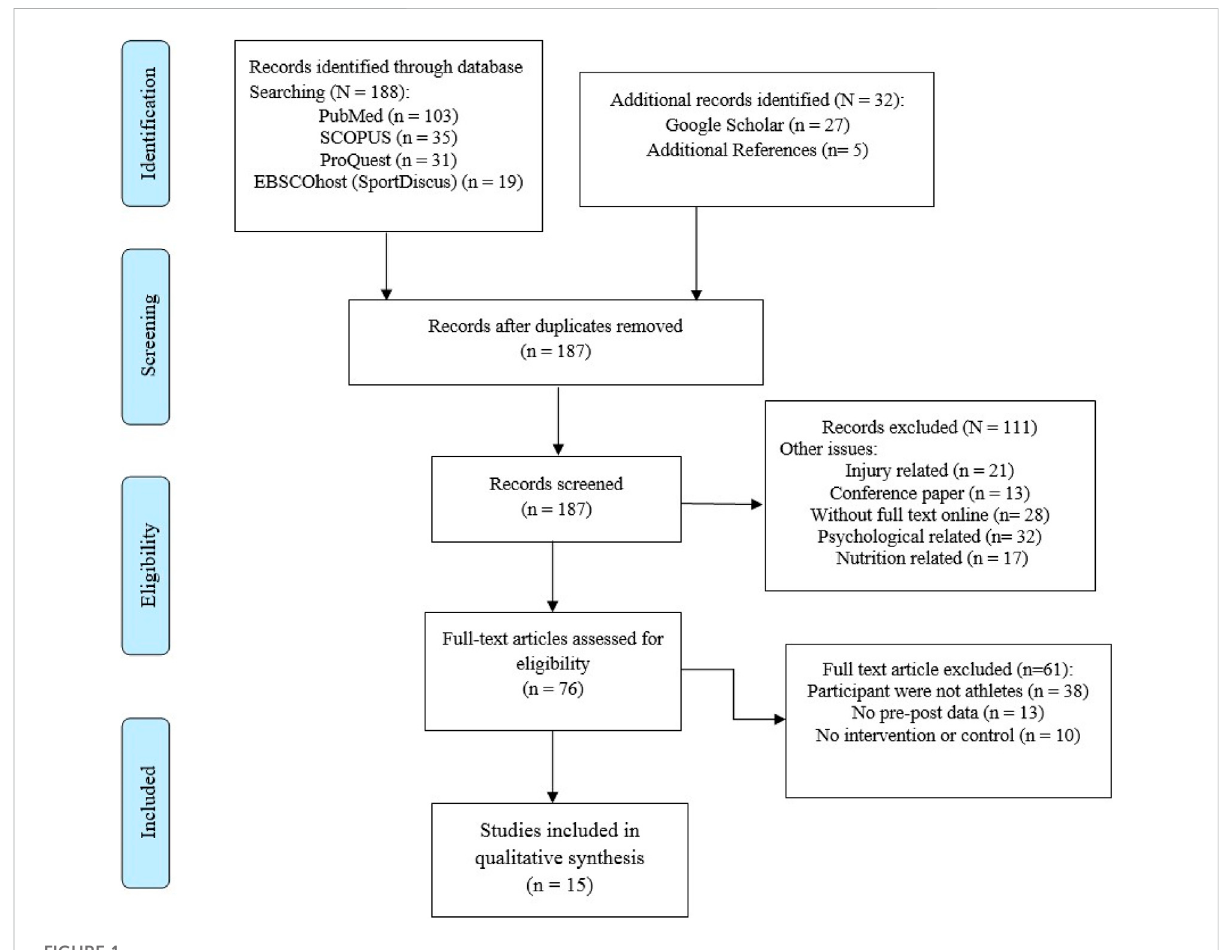
FIGURE 1 PRISMA fl ow chart of the study selection